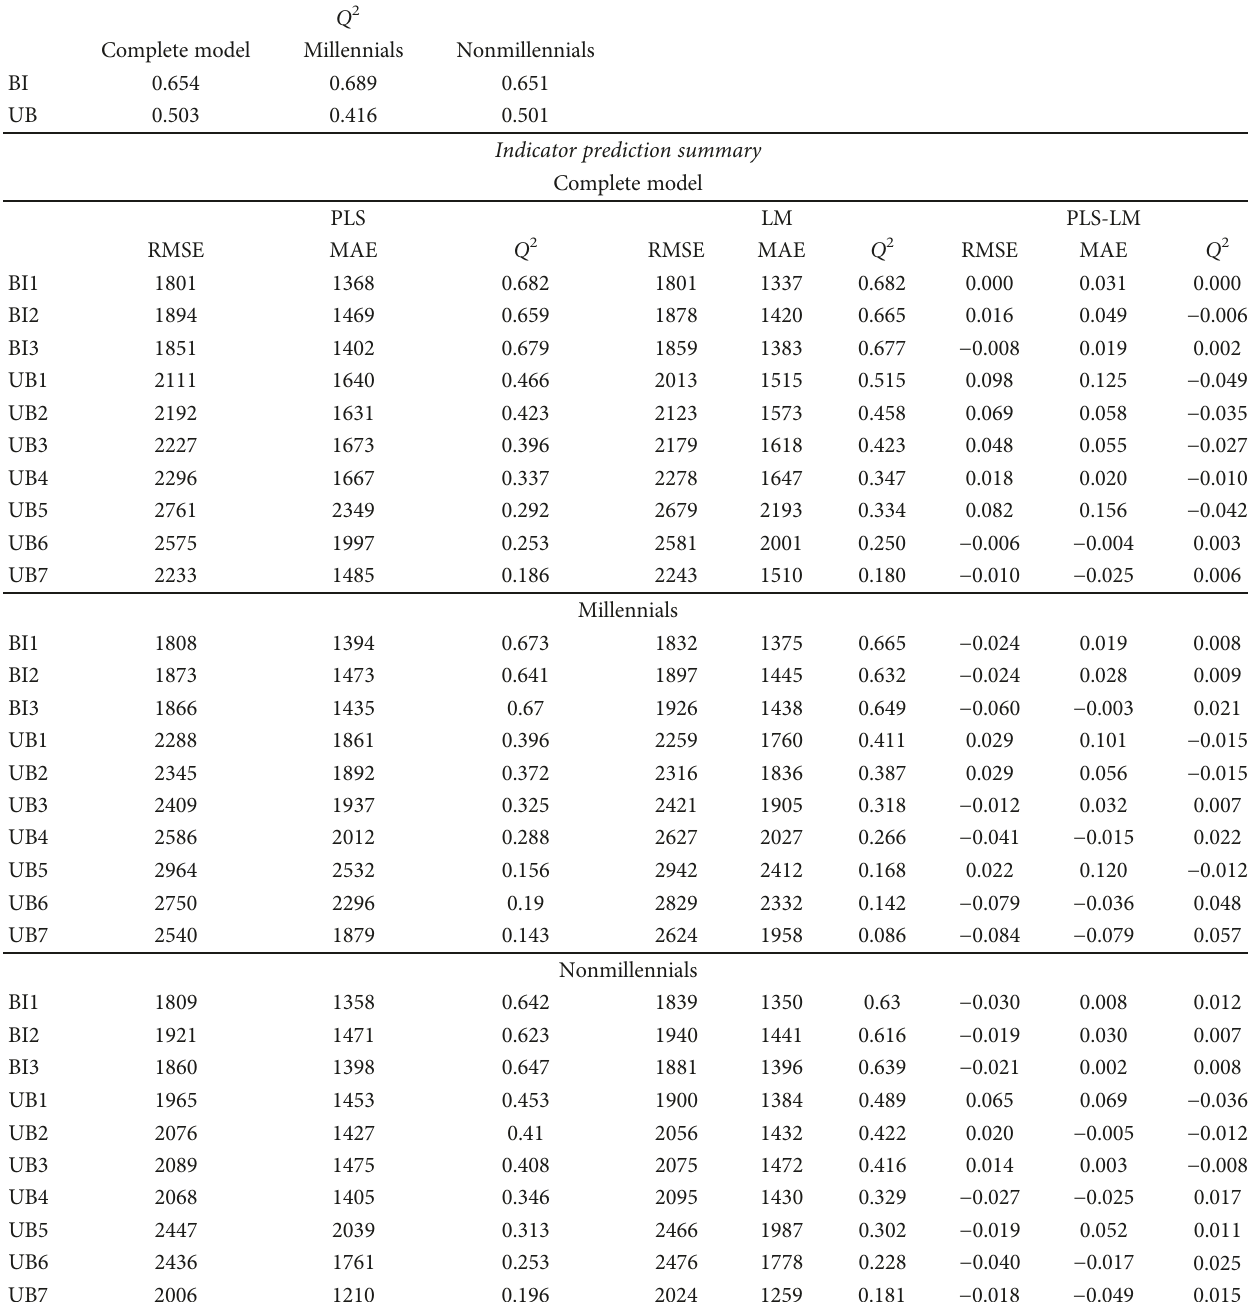
Table 8: PLS predict